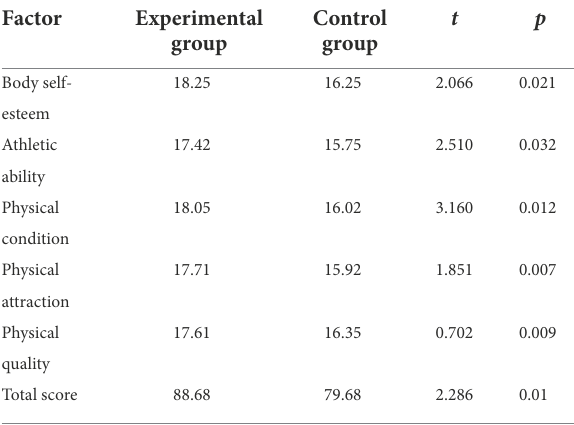
TABLE 11 Body esteem scale of the experimental group and the control group after the experiment.